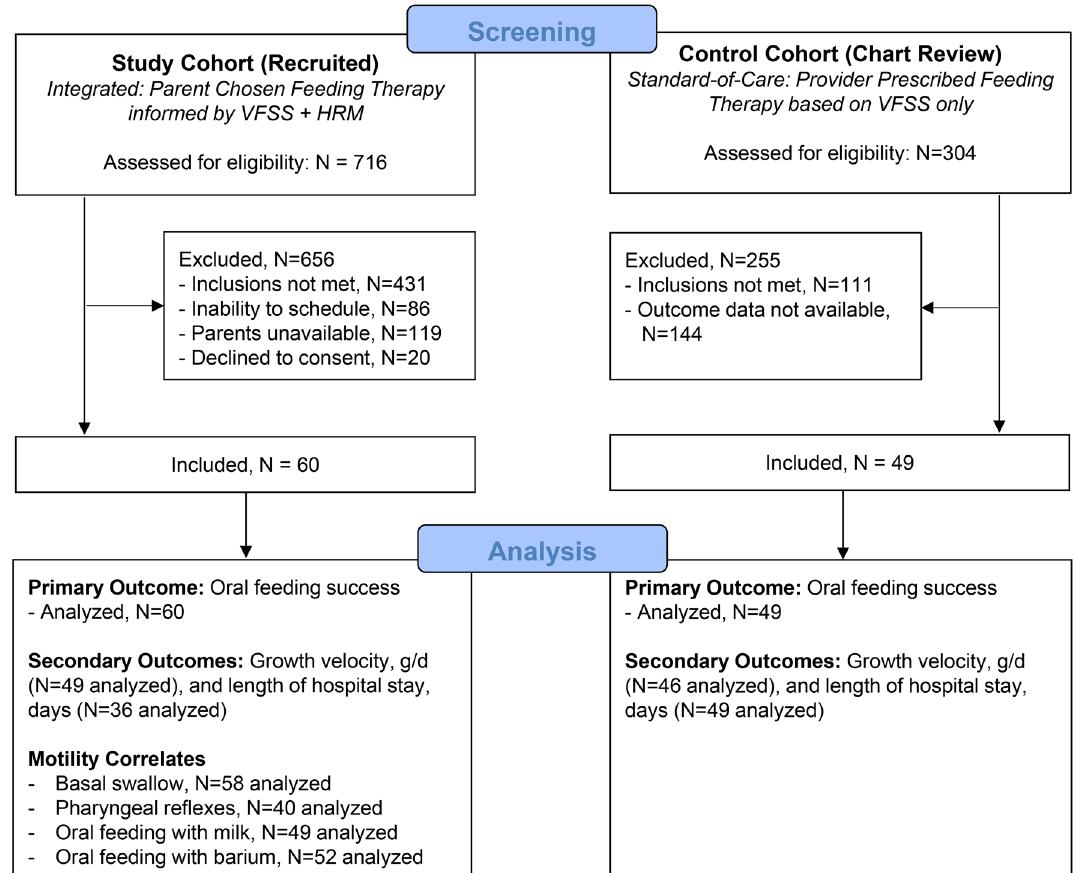
Figure 1. Study Enrollment. Depicted is the study flow diagram for analysis of study (prospectively collected) and control (retrospectively collected) cohort data for infants referred for VFSS study and control cohorts, or (b) in study infants with PAS = 1 vs control infants with PAS = 1 (Table 3). However, in infants with PAS ≥ 2, oral feeding success was greater in the study group (Table 3), specifically driven by those infants with penetration (Fig. 3). Feeding therapies in infants with PAS = 1 did not differ between study and con- trol groups ( P = 0.30), as well as infants with PAS ≥ 2 between study and control groups ( P = 0.29). HRM motility. In study infants with PAS ≥ 2 (vs PAS = 1): (a) PAS score was 4 2 – 8 vs 1 1 – 1 , p < 0.0001; (b) motility outcomes did not significantly differ for basal swallow or oral milk feeding (Table 4); (c) DA during interphase and symptoms were increased with pharyngeal infusions (Table 4); and (d) during oral feeding with barium sul- fate, VFSS feeding duration was 85.6 ± 10.3 vs 124.5 ± 16.2 s, p = 0.048, and distal esophageal contractile vigor was decreased (Table 4). Also note during oral feeding, pharyngeal contractile vigor was greater with barium sulfate (vs milk) (Table 4). A representative HRM figure comparing infants with and without penetration-aspiration during pharyngeal infusion and oral feeding is shown (Fig. 4). Discussion